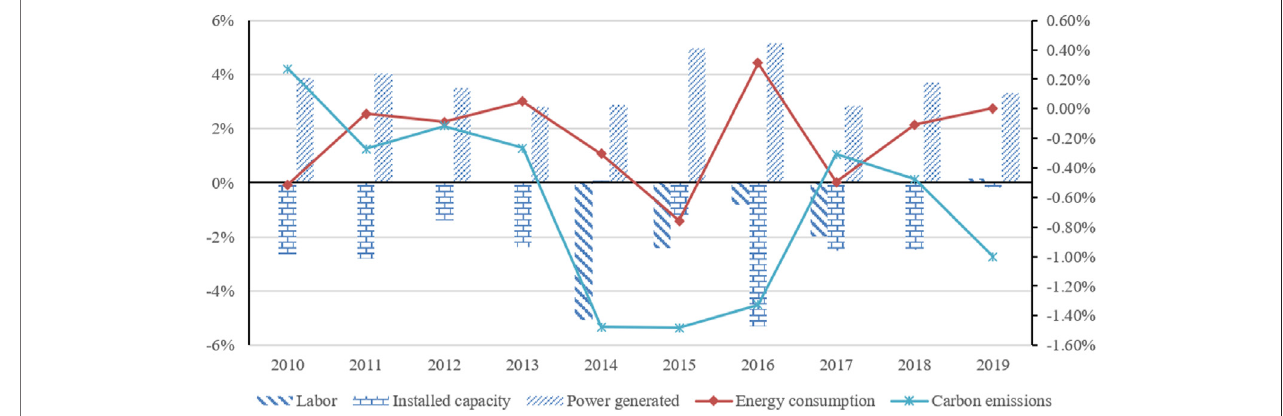
FIGURE 4 | Gap ratio of the inputs/outputs compared to the closest targets.